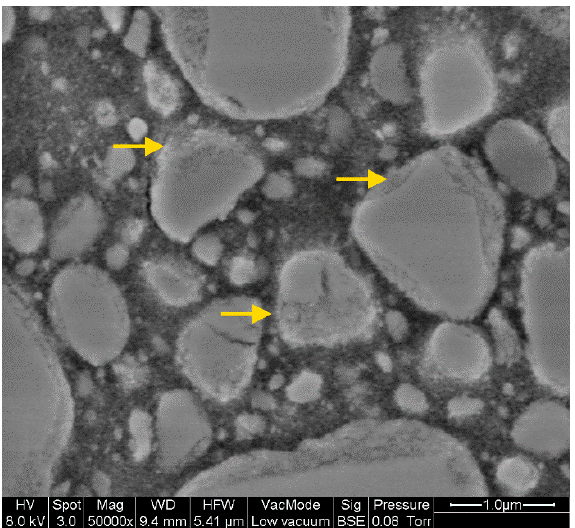
Figure 9. Example for porous edge area (yellow arrows) of filler particles in Lava Ultimate